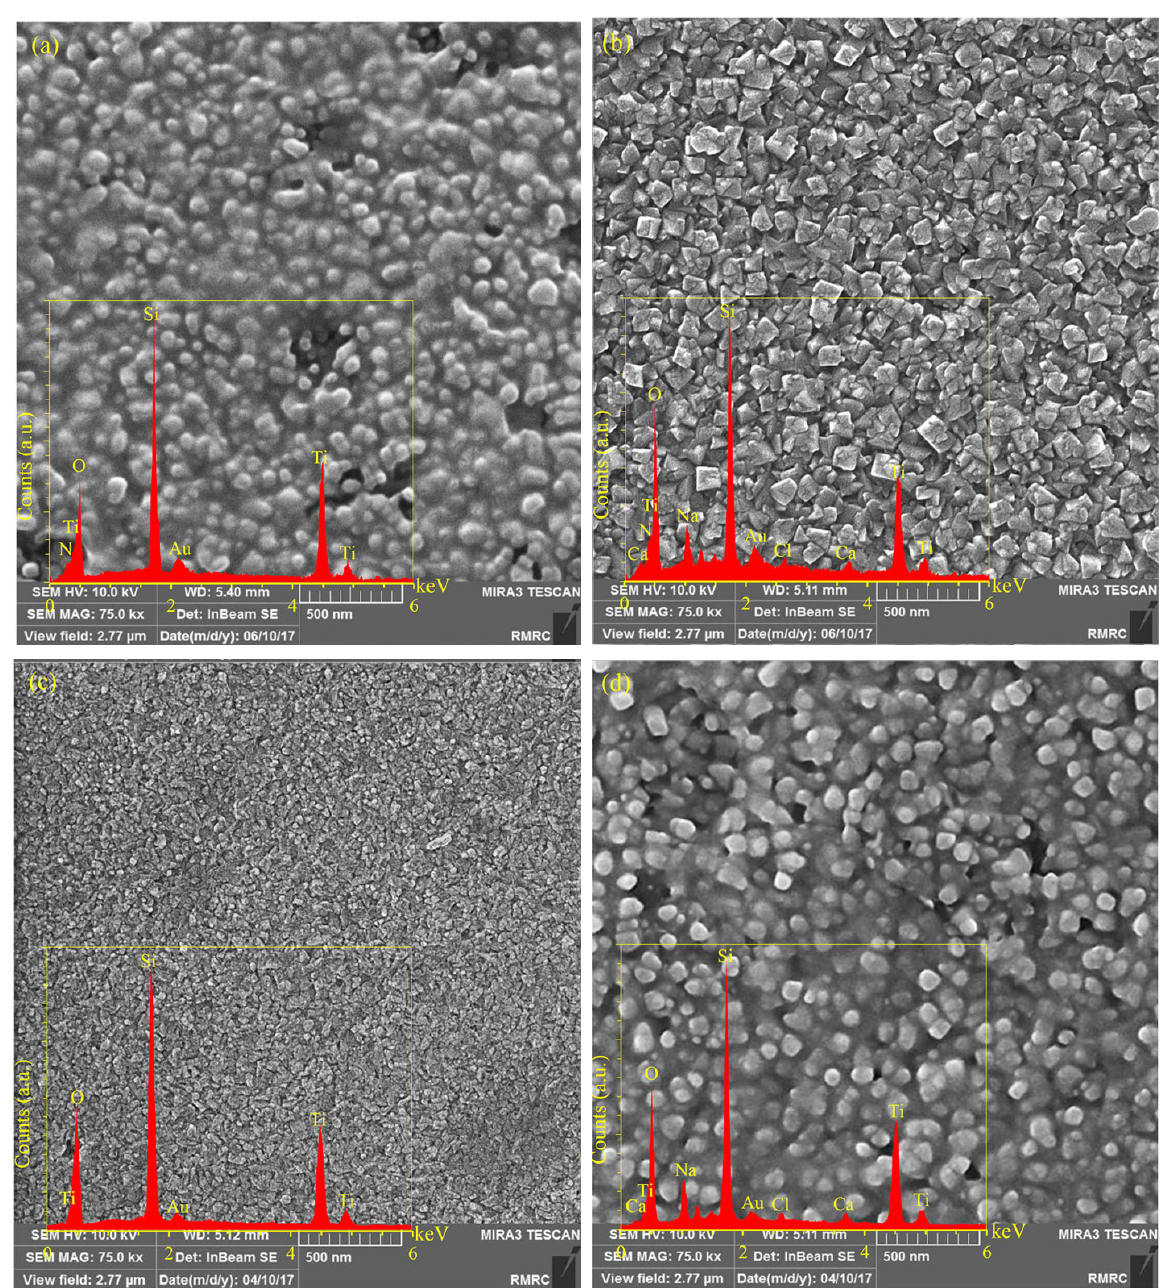
Fig. 2 FESEM images and EDS analysis results of (a) NTiO 2 -Q, (b) NTiO 2 -G, (c) TiO 2 -Q, and (d) TiO 2 -G thin film samples.